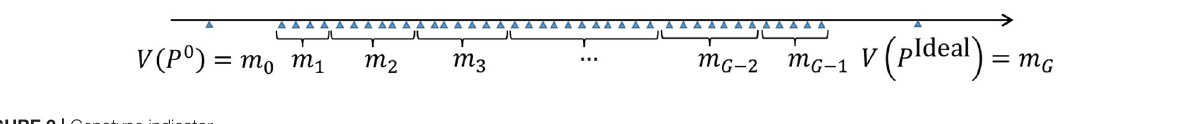
FIGURE 2 | Genotype